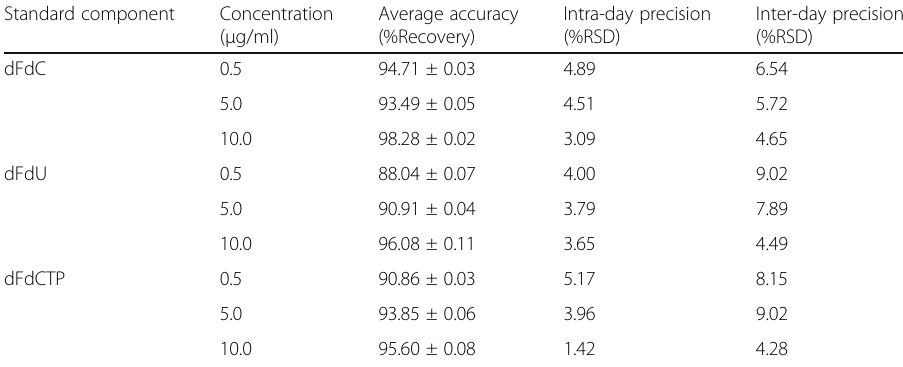
Table 3 Intra-day and inter-day precision and average accuracy Standard